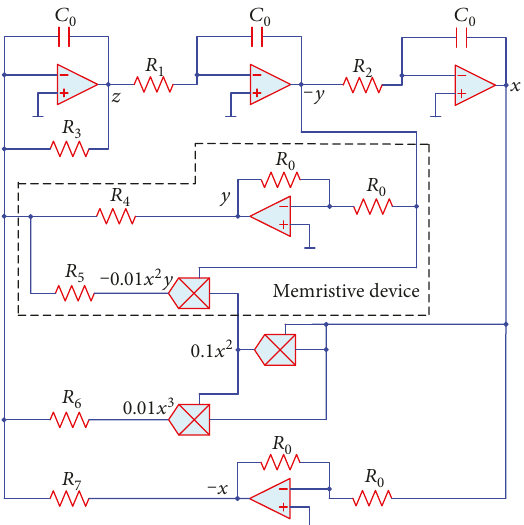
Figure 12: Electronic circuit realization of the emulating system